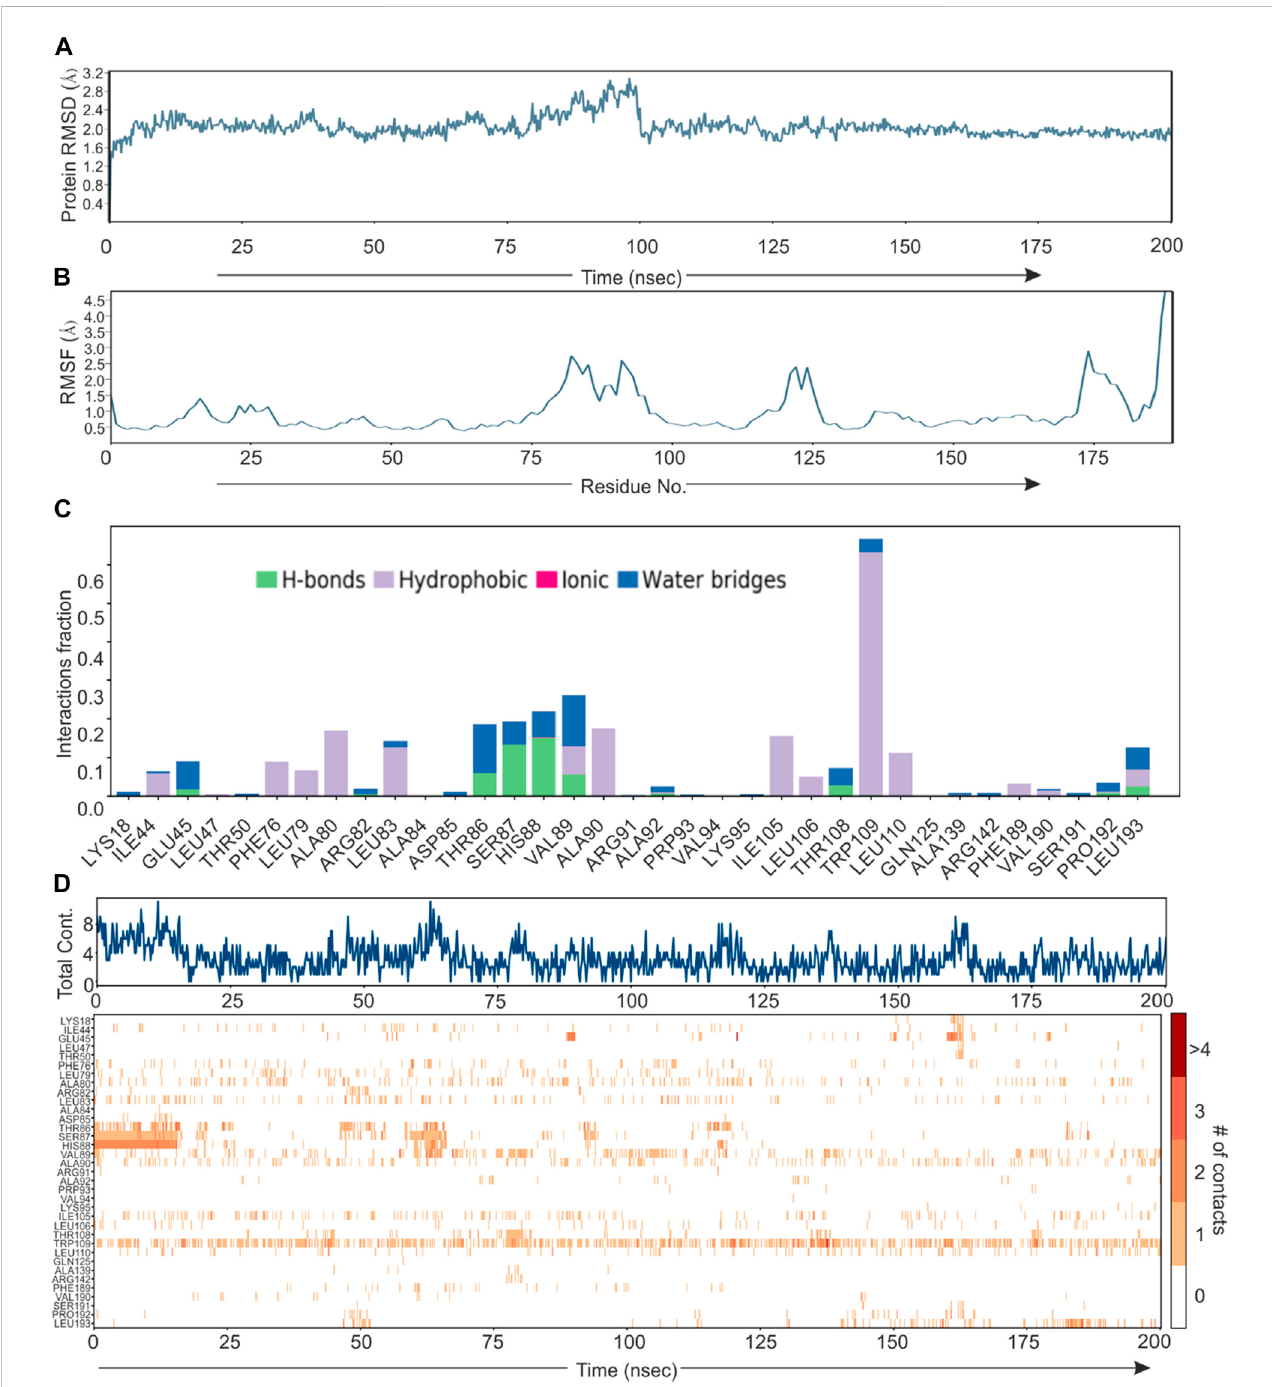
FIGURE 4 Rootmeansquaredeviationplot,InteractionplotandInteractiondynamicsofKSHV-encodedproteaseandLyso18:1. (A) TheKSHV-encodedproteaseis represented in blue color. X -axis represent the simulation time in nano second. (B) RMSF plot for KSHV-encoded protease. X-axis represents the residue number. (C) Interaction plot of KSHV-encoded protease with PLA. Y -axis represent the total number of contact fraction per residue per simulation time i.e. if theresidue(presentedon X -axis)has onecontact during thewholesimulationof200 ns. (D) Interaction dynamicsof KSHV-encoded protease with PLA. Glu 166 predominantly interacts with thea fl avin digallate having contact varies from 2 – 4. The total number of contacts during simulation were